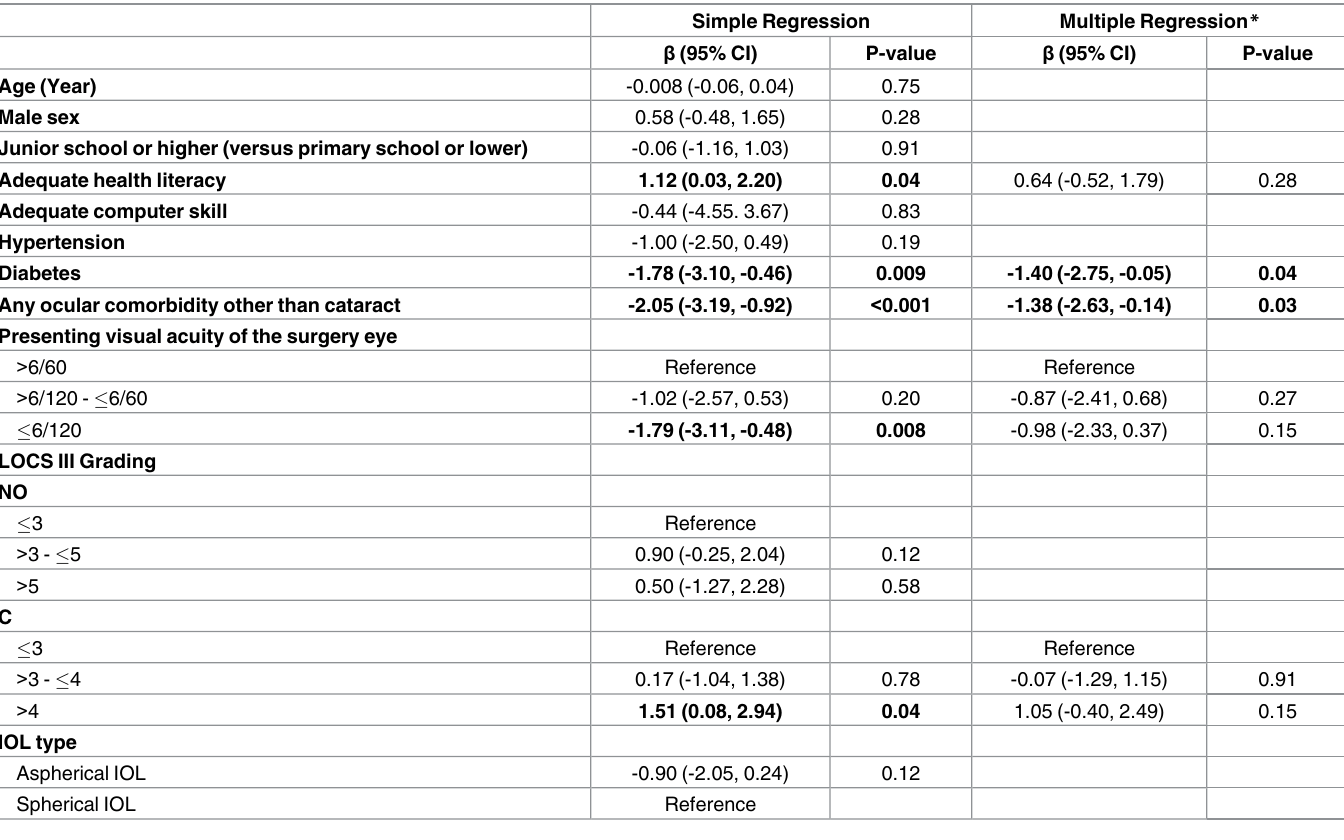
Table 6. Linear regression of potential predictors of the discrepancy between actual and expected postoperative Catquest-9SF scores (N = 174). Simple